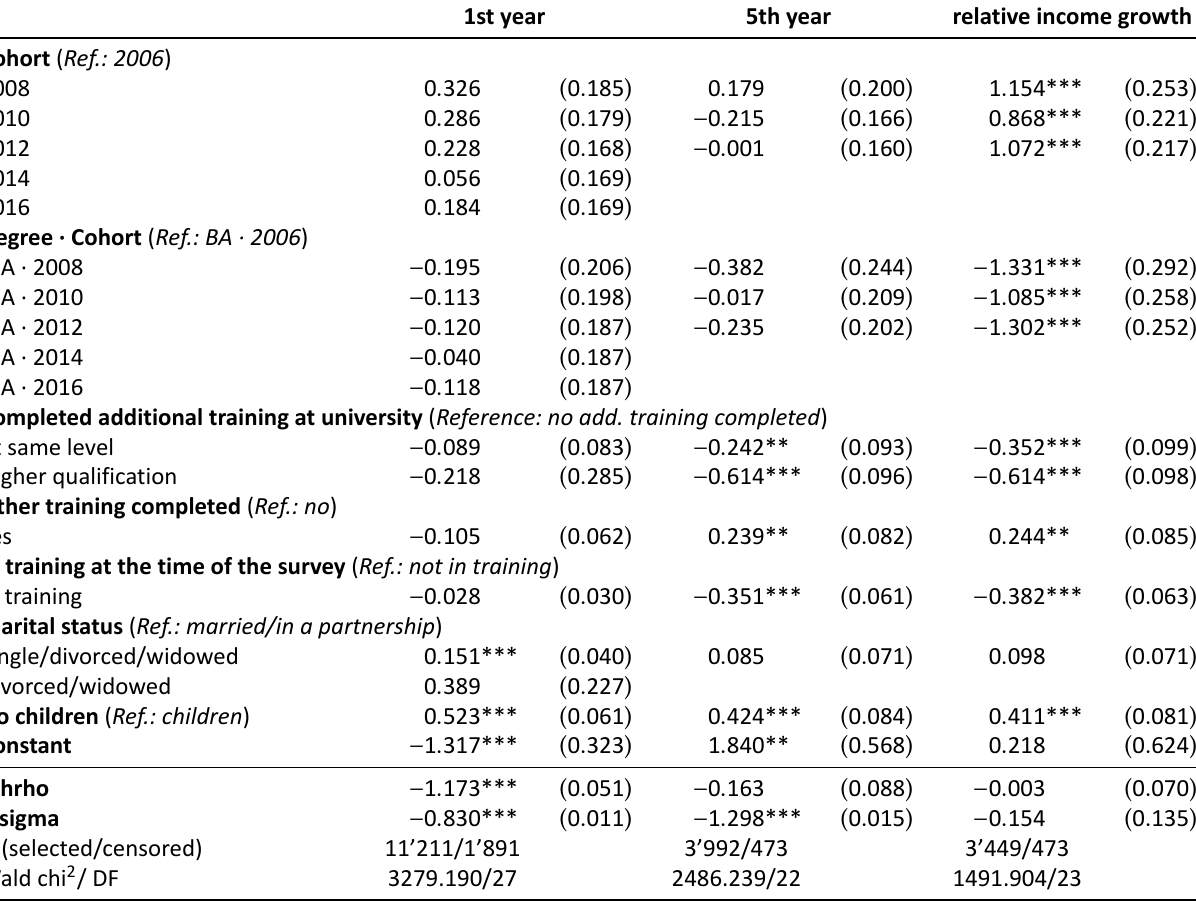
Table A6. (Cont.) Women’s monthly income (log.) in the first and fifth year after graduation and their relative income growth; models with interaction terms—shown in Figure